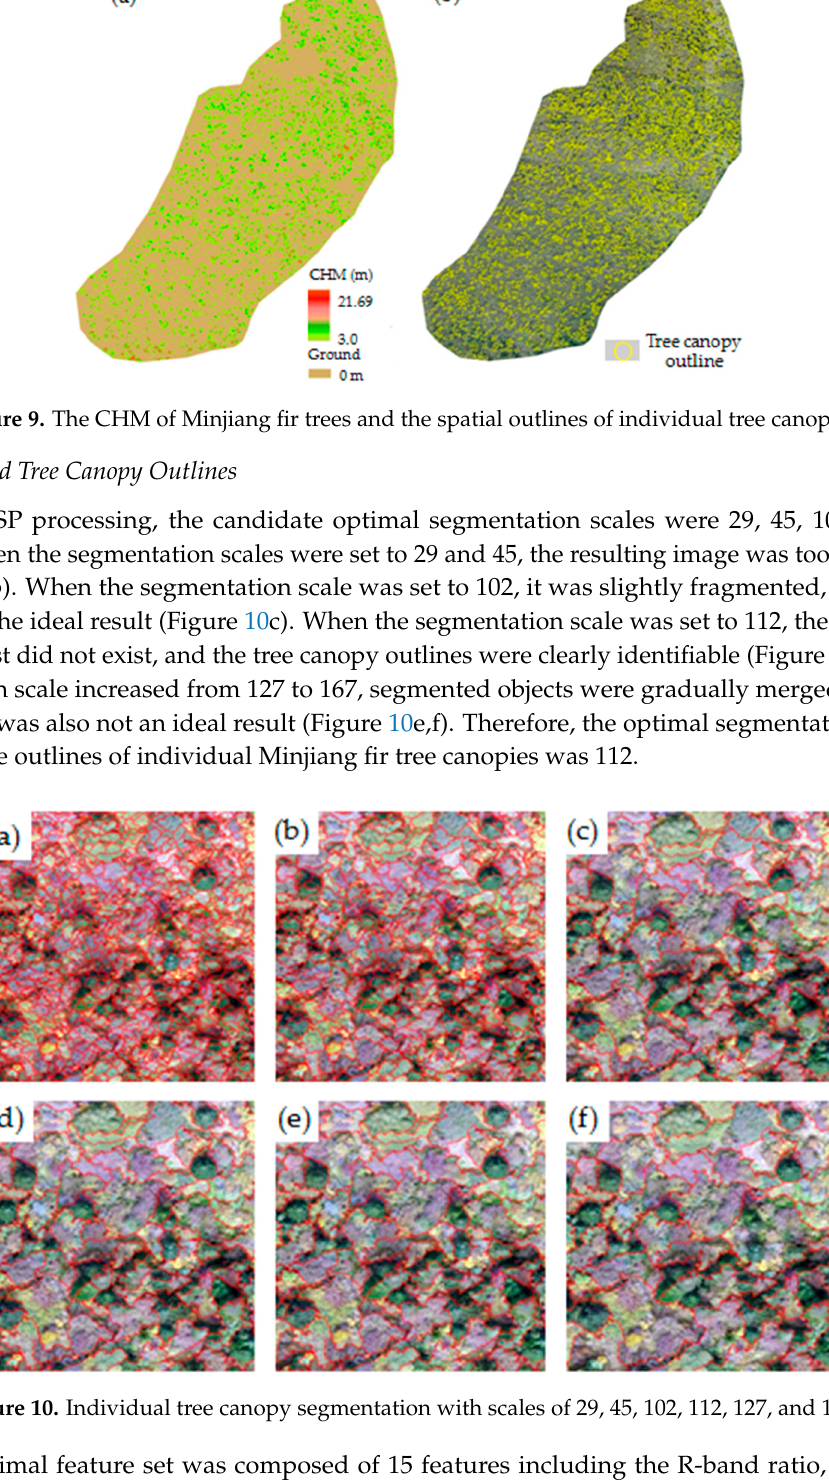
Figure 8. Comparison between the original DSM and the DSM with low vegetation removed.